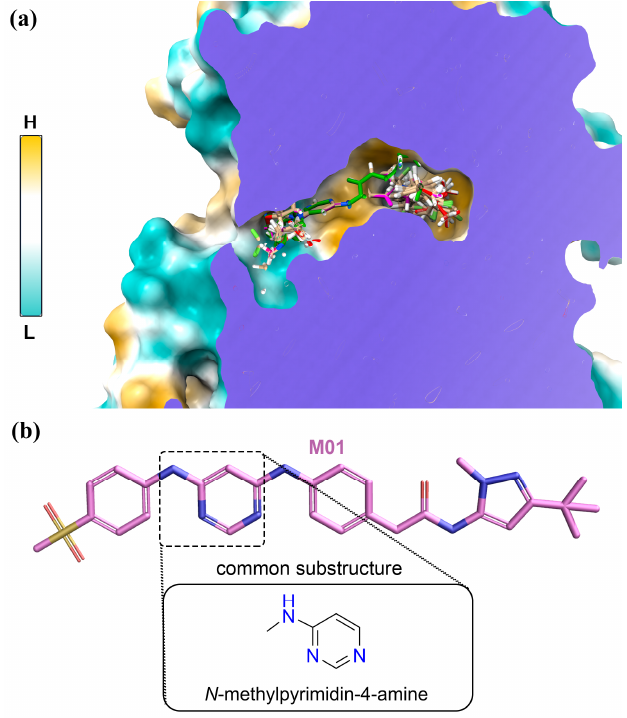
Figure 7. Common substructure-based molecular alignment. ( a ) Alignment of the compounds is shown inside the hydrophobic binding pocket of FLT3 by Z-plane clipping. Cyan to gold-yellow color bar indicate low (L) to high (H) hydrophobicity. ( b ) Common substructure of the compounds in the dataset.